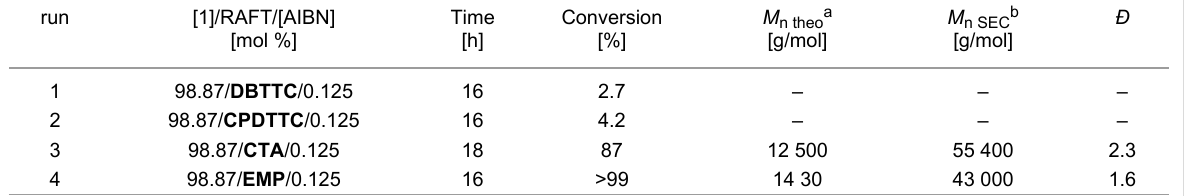
Table 3: RAFT polymerization of MLA with different RAFT agents in a ratio of 98.87:1:0.125 ([MLA]/[RAFT]/[AIBN]) (80 wt % 1,4-dioxane, at 70 °C). run